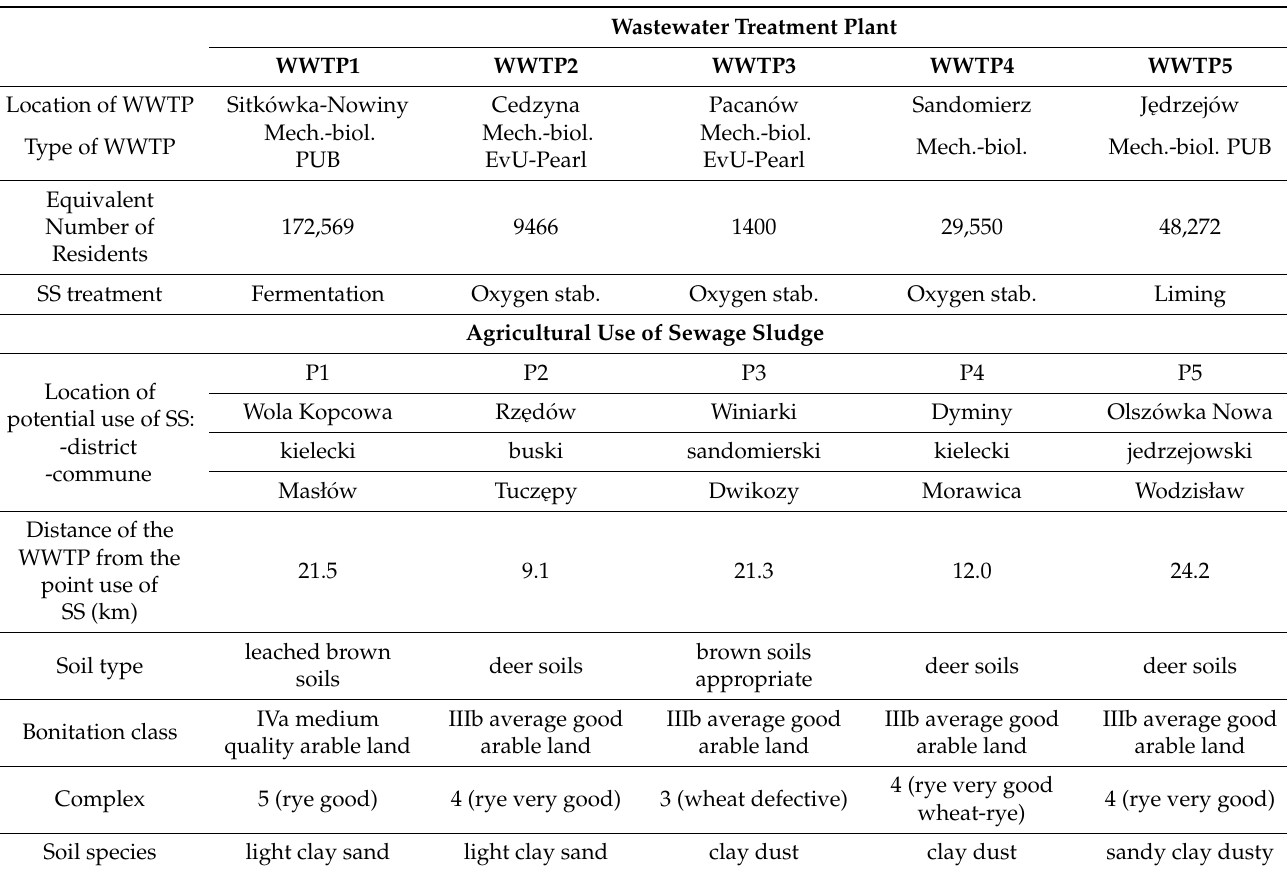
Table 1. Characteristics of wastewater treatment plants (WWTPs) and potential sites of agricultural use of sewage sludge [37,38]. Wastewater Treatment